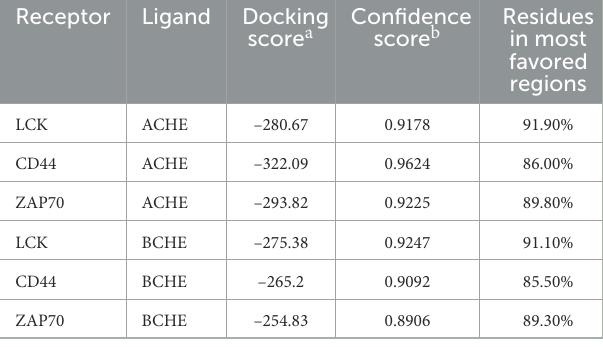
a DockingScore:Dockingscorerepresentthepossibilityofbinding.Amorenegativedocking scoremeansamorepossiblebindingmodel. b Confidence Score: Represent the binding likeliness of two proteins, the receptor and ligand wouldbeverylikelytobindiftheconfidencescoreisabove0.7.